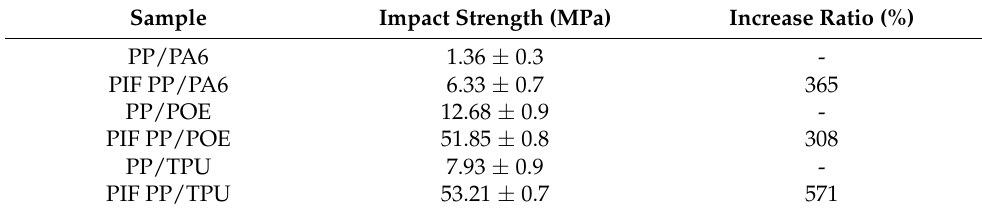
Figure 7. Impact performance of blends before and after PIF . Table 6. Impact strength and Increase ratio of blended materials. Table 6. Impact strength and Increase ratio of blended